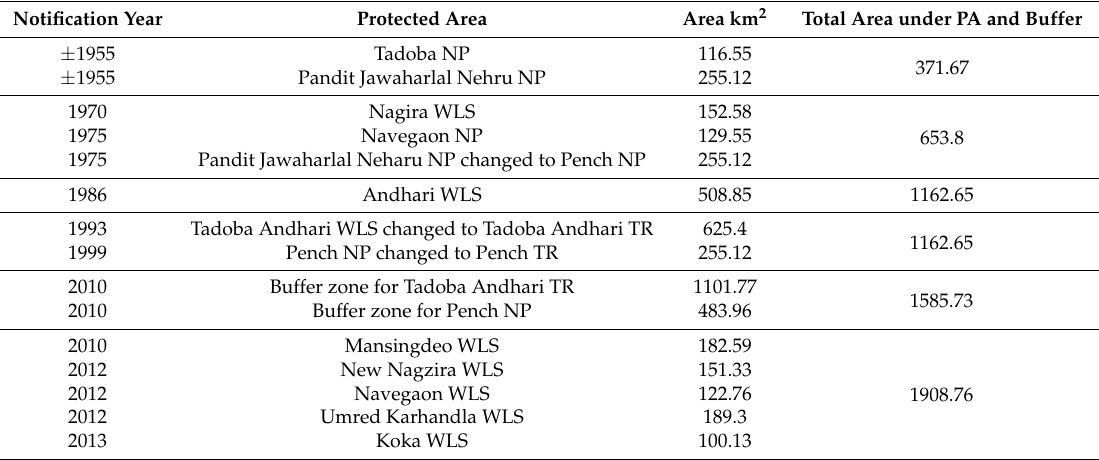
Table 3. Year of establishment as well as transition to different forest management regimes along with the respective and cumulative area under PA and buffer zone.